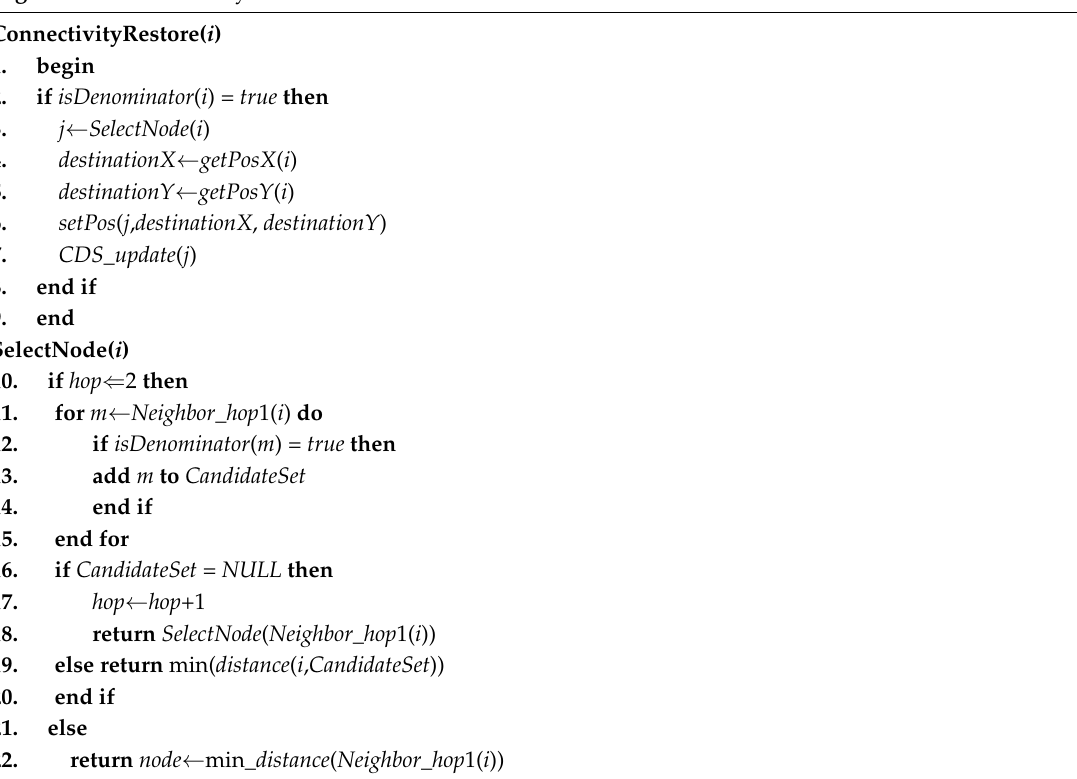
Algorithm 1. Function SelectNode ( i ) returns the optimal alternative node selected from the neighbor nodes of node i . Algorithm 2 Connectivity